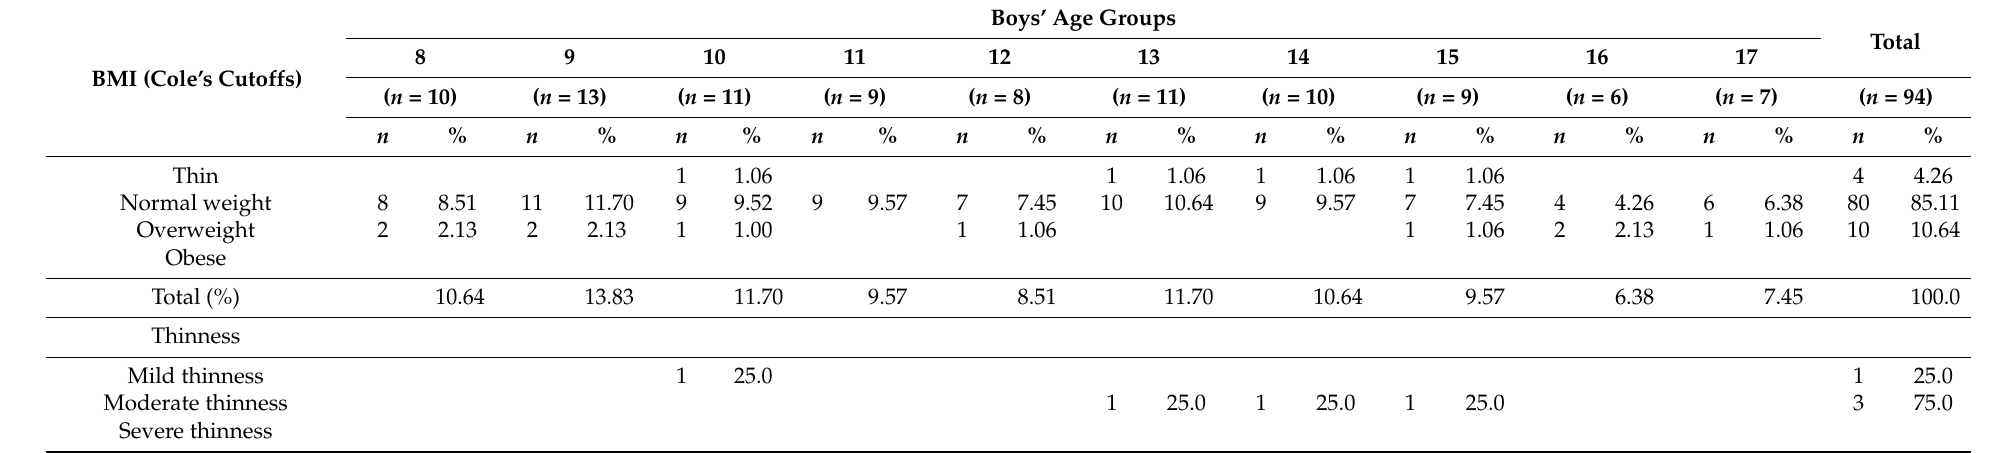
Table 2. Body mass index distribution of participants according to International Obesity Task Force